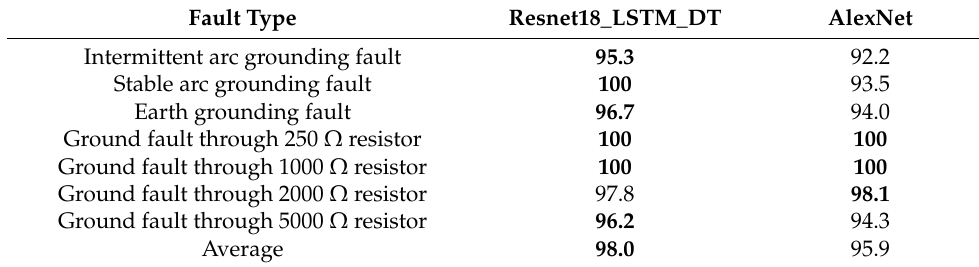
Table 6. Average correct identification rate of single-phase grounding fault types (%). Fault